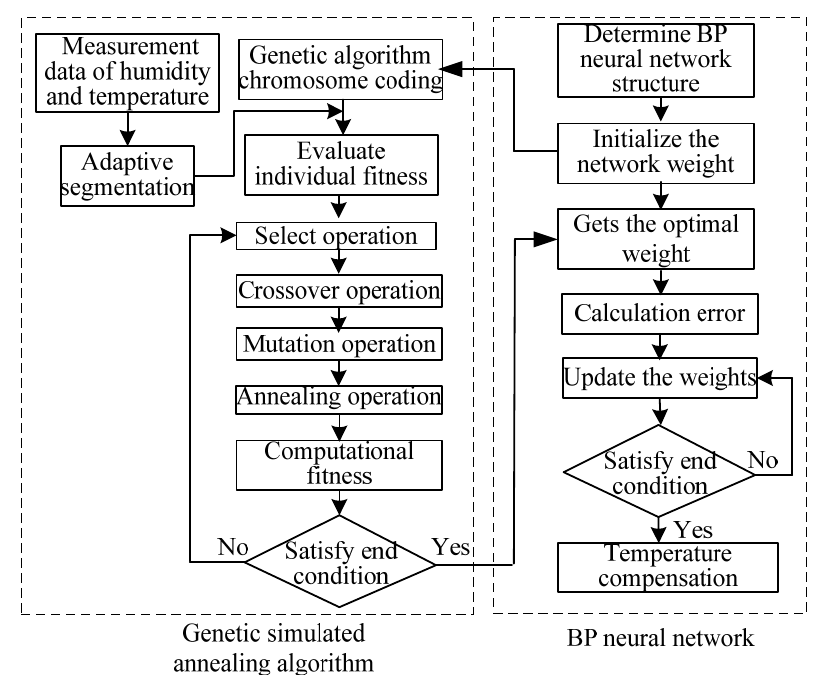
Figure 5. Flow chart of compensation algorithm based on genetic simulated annealing (GSA-BP).